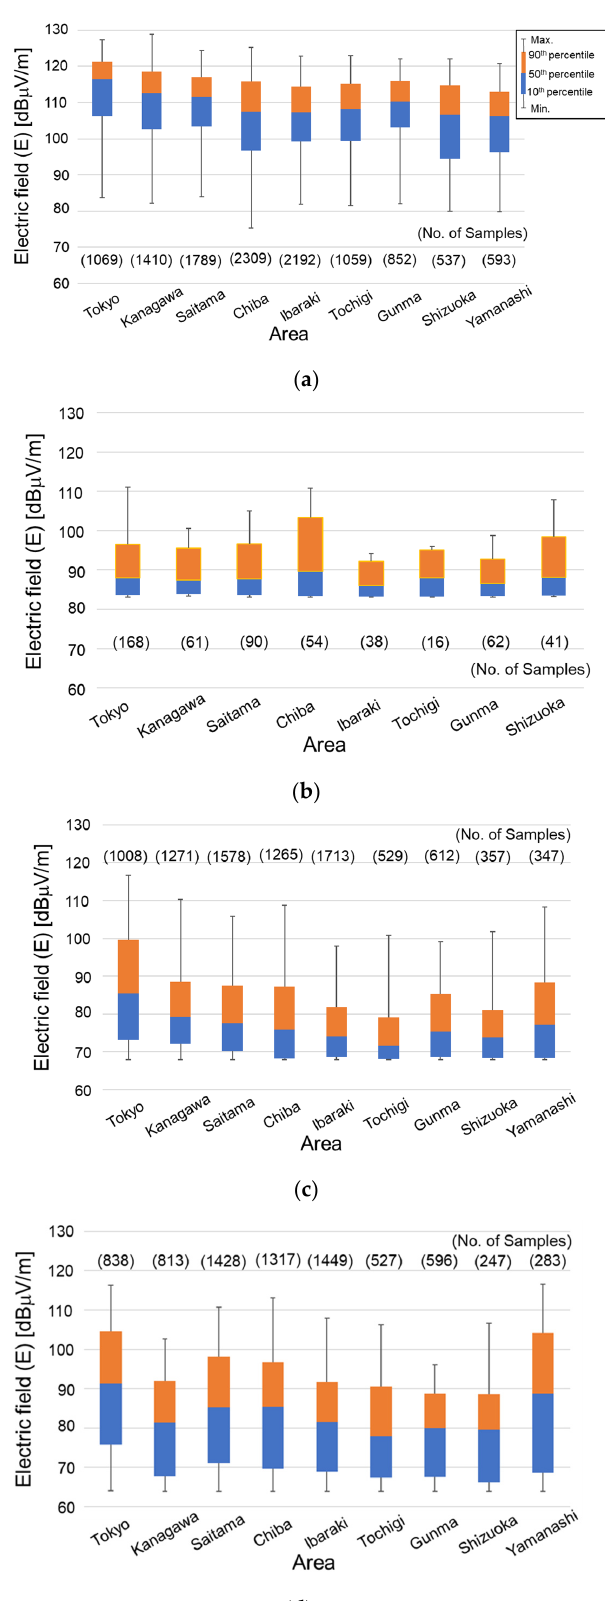
Figure 5. Box plot of E-field strength for each prefecture. ( a ) Mobile systems (including 5G); ( b ) 5G; ( c ) FM; ( d ) TV.